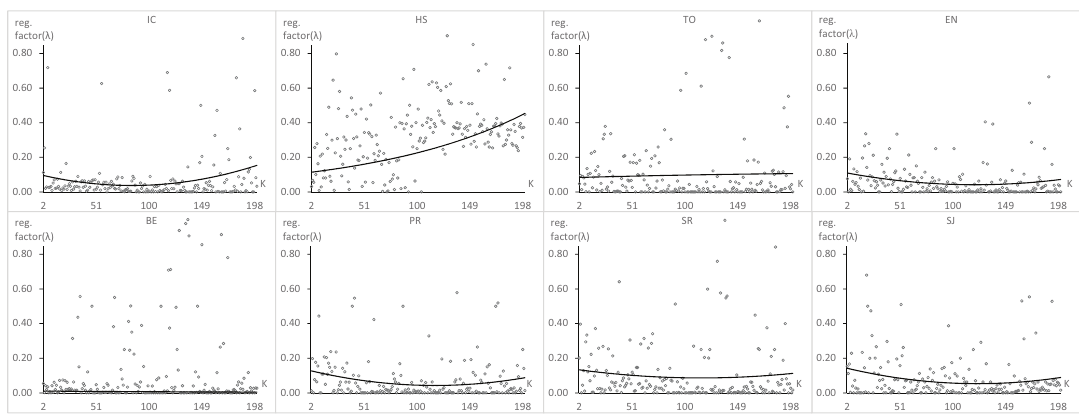
Figure 9. Optimal value of the regularization factor λ for each value of K .